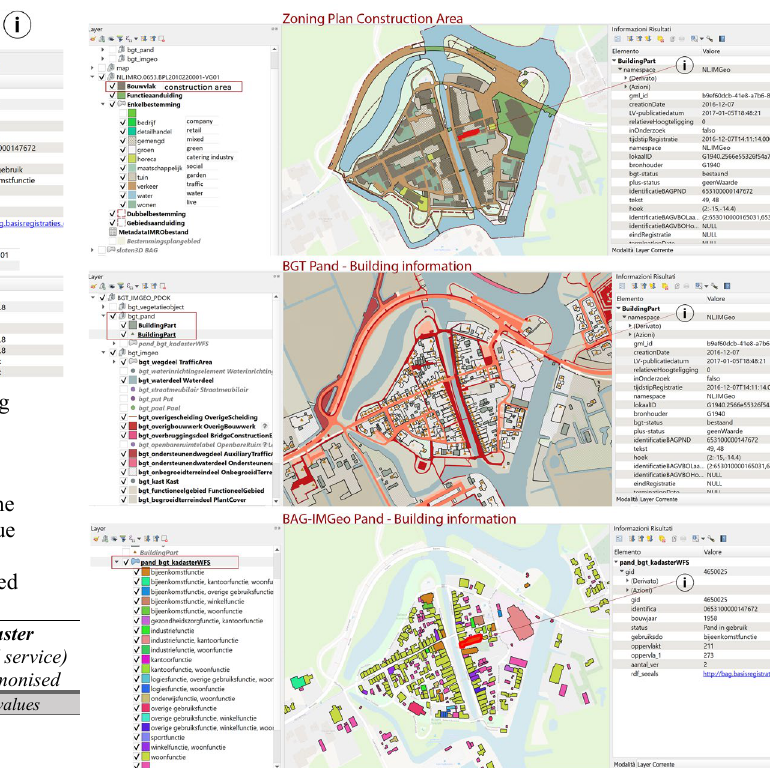
Figure 6. Datasets comparison of BGT, BAG - IMGeo and Zoning Plan entities Building and Construction Area in